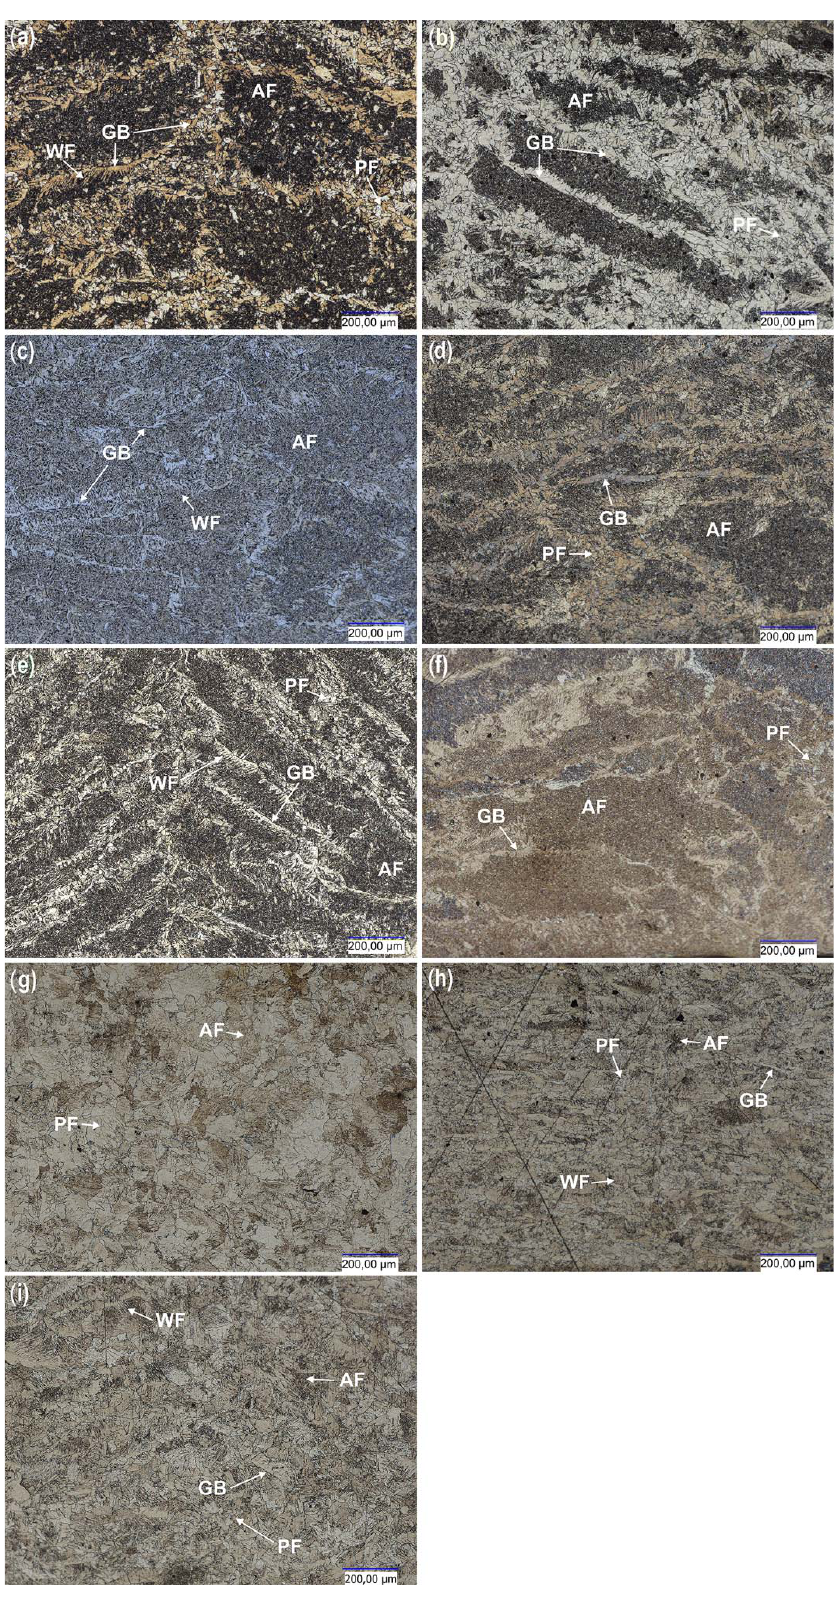
Figure 6. Representative microstructures of cross-sections of joints depending on the bonding process used: ( a ) manual MAG135, ( b ) manual MAG138, ( c ) robotic MAG135, ( d ) robotic MAG138, ( e ) CMT solid wire, ( f ) CMT flux cored wire, ( g ) butt welding, ( h ) robotic laser, ( i ) manual laser with solid wire.